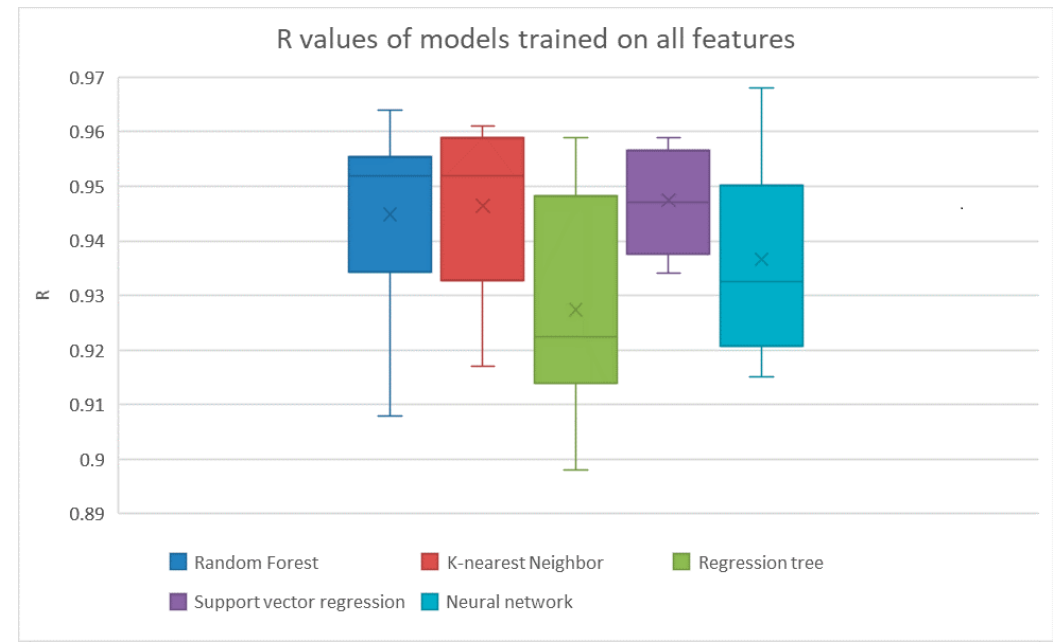
Figure 2. The results from linear regression and Bayesian ridge regression were much lower than the other models, so their results are not shown here. The results are shown explicitly in Table 3.